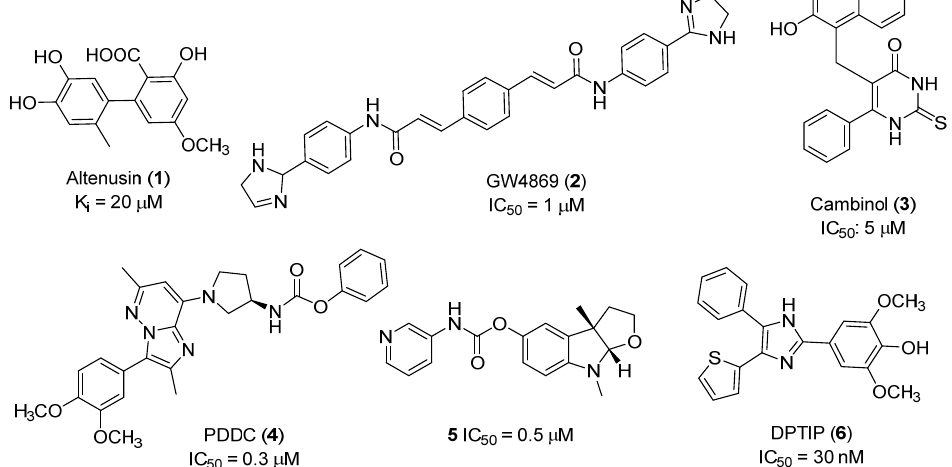
Figure 1. Selected non-competitive inhibitors of human nSmase2.